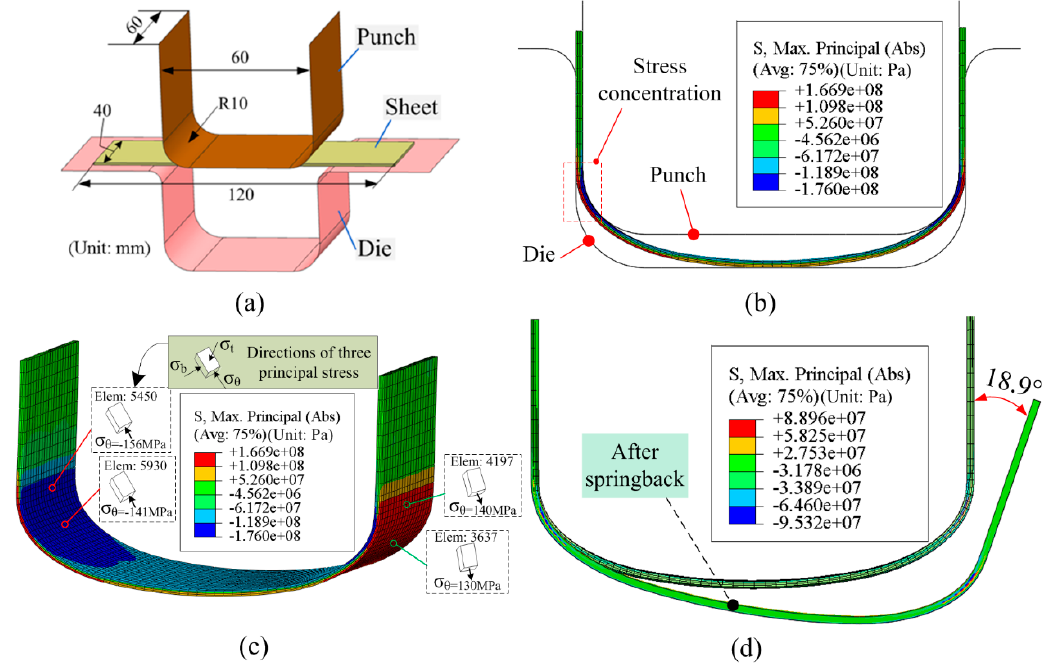
Figure 2. Structure-field model. ( a ) Geometric dimension; ( b ) 2D view of stamping; ( c ) 3D view of stamping; ( d ) angle in 2D view after springback.